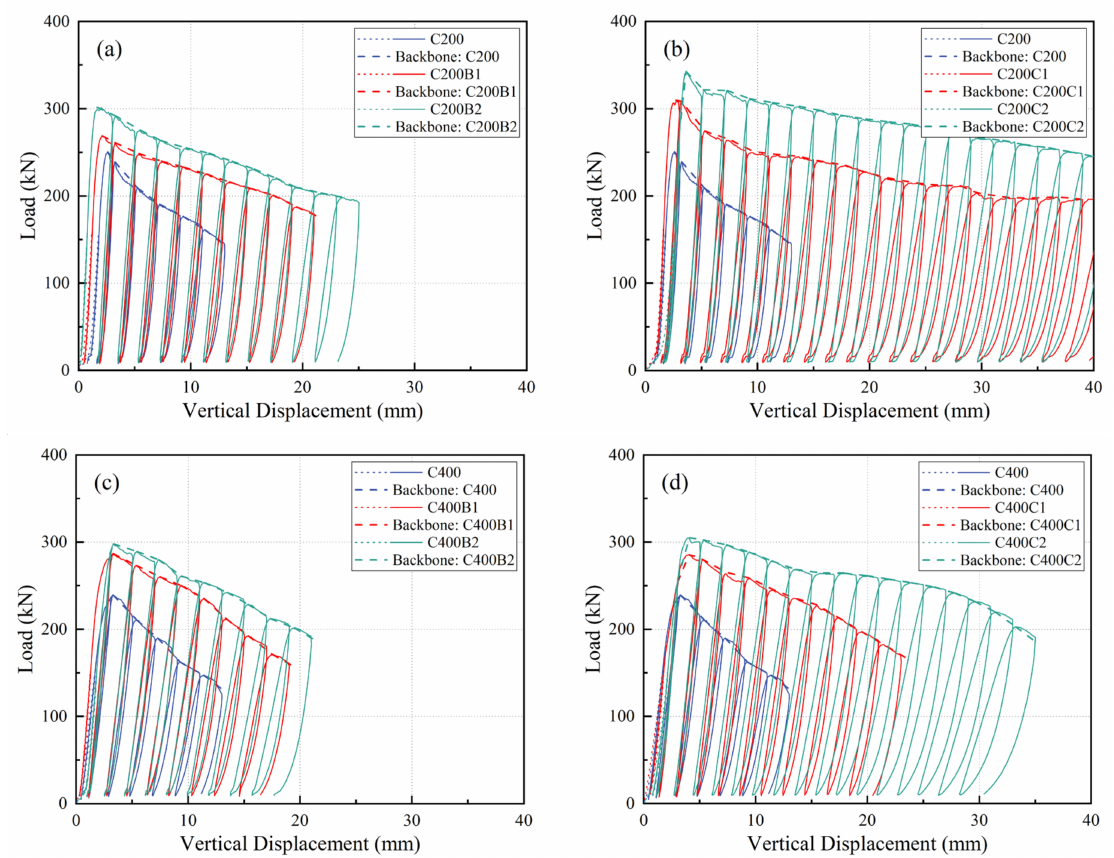
Figure 8. Hysteresis loops and backbone curves of FRP confined CLT columns: ( a ) BFRP confined C200 specimens; ( b ) CFRP confined C200 specimens; ( c ) BFRP confined C400 specimens; ( d ) CFRP confined C400